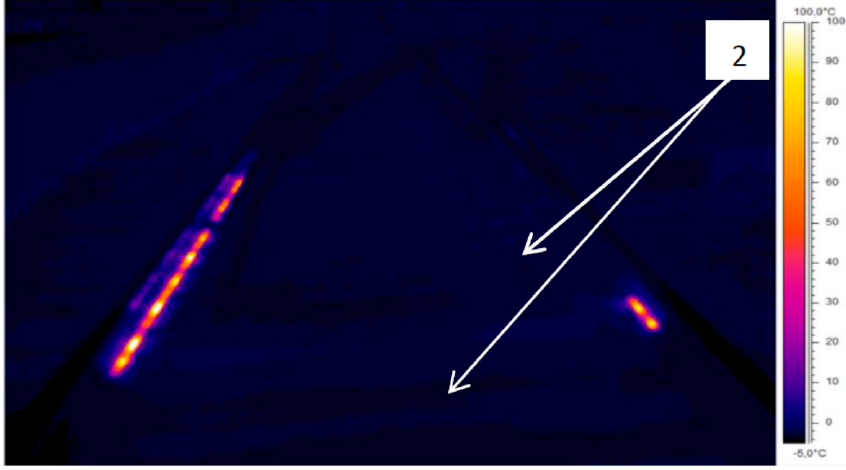
Figure 11. Thermogram IR_0145—iron colour palette (source: authors).